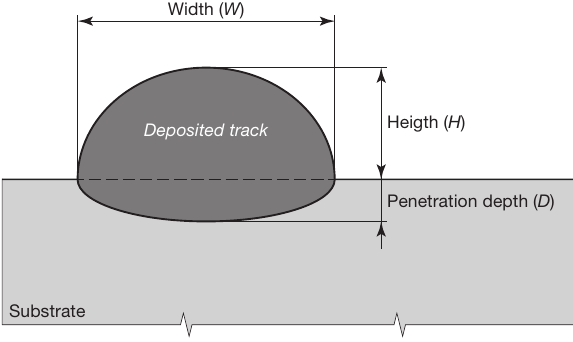
Figure 9. Schematic of measures for each single